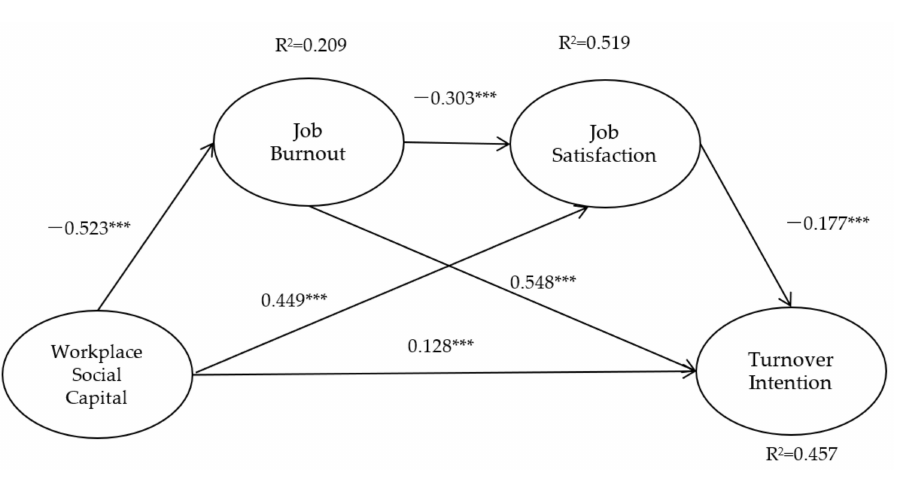
Figure 1. The results of double-mediator model. Note. *** p <